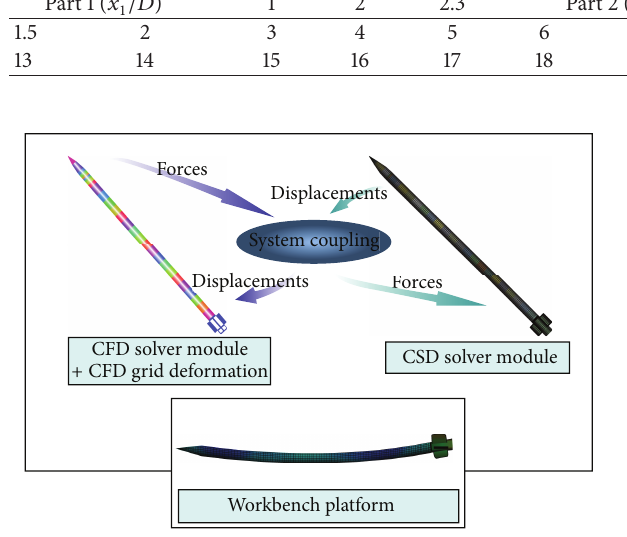
Figure 1: Scheme of CAE code ANSYS Workbench.